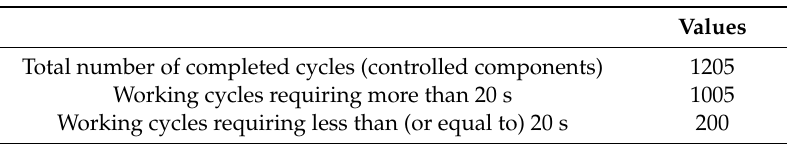
Table 3. Numerical